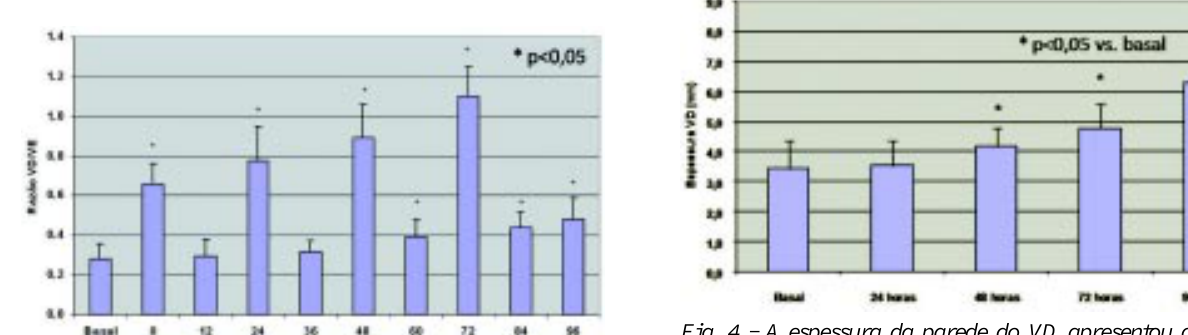
Fig. 4 - A espessura da parede do VD apresentou aumento significativo a partir do momento 48 horas ao longo do protocolo de sobrecarga sistólica intermitente imposta ao VD nos quatro grupos de estudo. n = 28 (Basal e 24 horas); n = 21 (48 horas); n = 14 (72 horas); n = 7 (96 horas). Valores (mm) = média ± desvio padrão. * = p<0,05 vs.